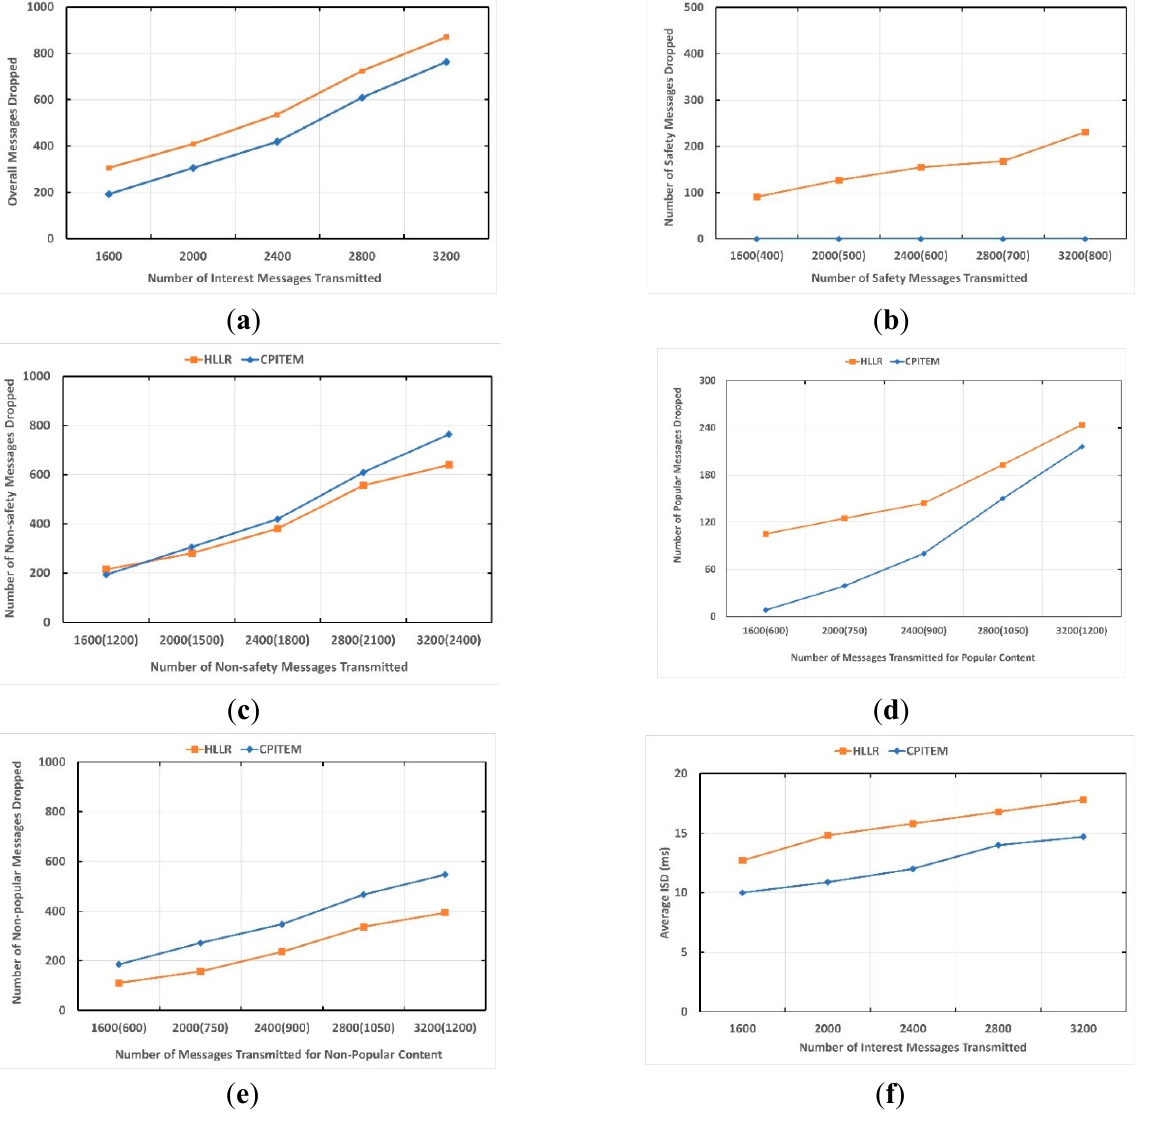
Figure 1. Experiment 1: total number of drop Interest messages as a function of growth in interest messages. ( a ) Overall Interest messages dropped as a function of Interest message growth in the network, ( b ) Interest messages related to safety dropped as a function of Interest message growth in the network, ( c ) interest messages related to non-safety dropped as a function of Interest message growth in the network, ( d ) Interest messages related to popular, non-safety content dropped as the number of Interest messages in the network increases ( e ) Interest messages related to non-popular, non-safety content dropped as a function of Interest message growth in the network, ( f ) average interest satisfaction delay.